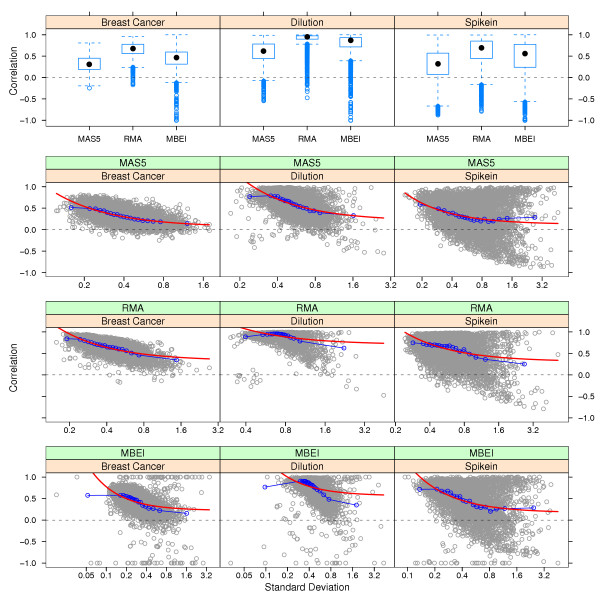
Correlations between the unnormalized expression values of 5000 randomly selected pairs of genes. Top: The distribution of the correlation coefficients is centered far away from zero for all expression measures and data sets. Bottom: Scatterplots of the correlations versus the product of the standard deviations of the genes for the randomly selected pairs. Local mean correlations are shown in blue and indicate that correlations decrease with variability. Shown in red is a simple model for lack of normalization that was fitted to the data.